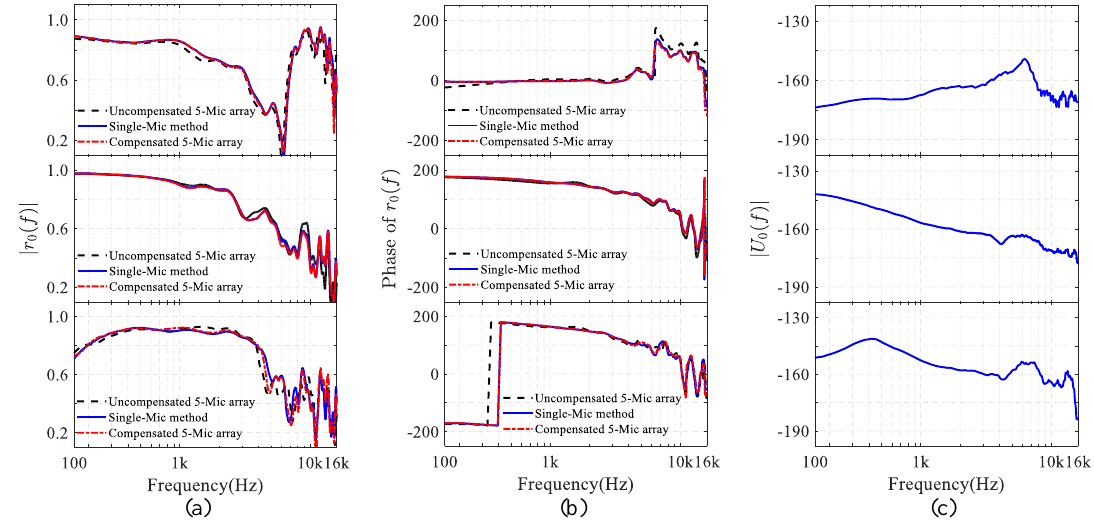
Figure 5. (Color online) Measurement results of the acoustic parameters for three different types of headphones ( First row : Huawei AM12 insert headphone; Second row : Beyerdynamic DT880 semi-open circumaural headphone; Third row : AKG K550 closed-back circumaural headphone). ( a ) The magnitude responses of the headphone acoustic reflectance; ( b ) The phase responses of the headphone acoustic reflectance; ( c ) The magnitude responses of the headphone Norton equivalent volume velocity source (NEVVS).